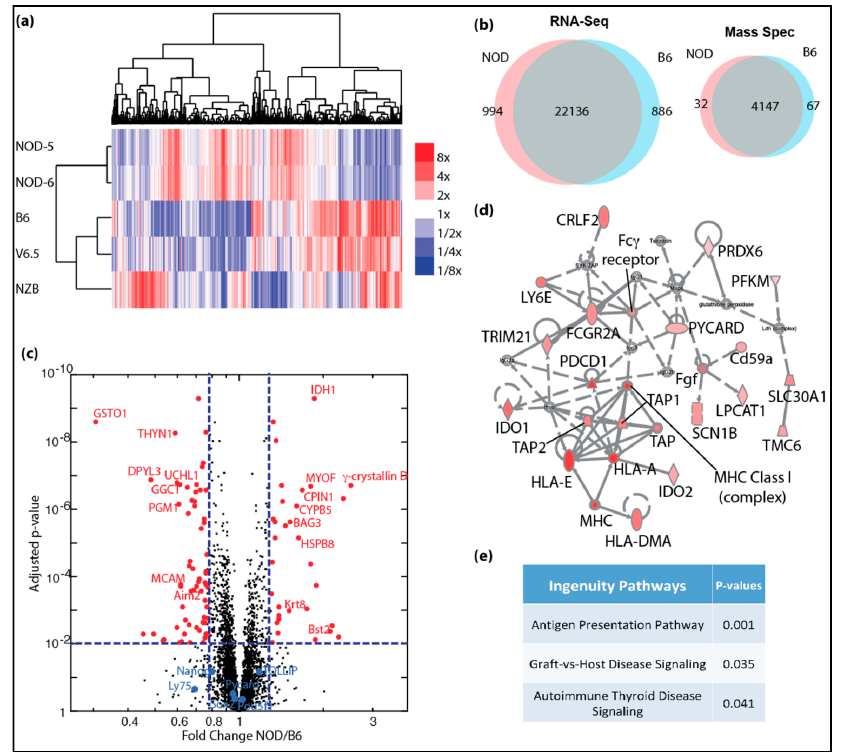
Figure 1. Genome-wide transcriptomic and proteomic analyses of autoimmune-prone ES cell lines: ( a ) heatmap shows clustering of differentially expressing genes identified in mRNA-Seq for NOD, B6, V6.5 and NZB ES cell lines, color scale bar shows expression level relative to average; ( b ) venn diagrams show overlap of genes with similar expression levels (left) and protein expression (right) in NOD and B6 ES cells; ( c ) volcano plot shows significantly increased protein expression in NOD (red dots, right) and in B6 (red dots, left) ES cells. ( d ) Ingenuity pathway analysis shows majority of proteins in the inflammation pathway are up-regulated (red) with 2-fold or more up-regulation and FDR < 0.05. ( e ) Ingenuity canonical pathways that are enriched in genes that are up-regulated in NOD ES